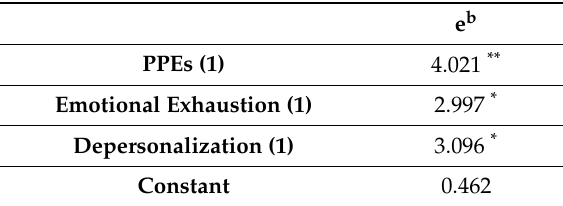
Table 3. Binary logistic regression